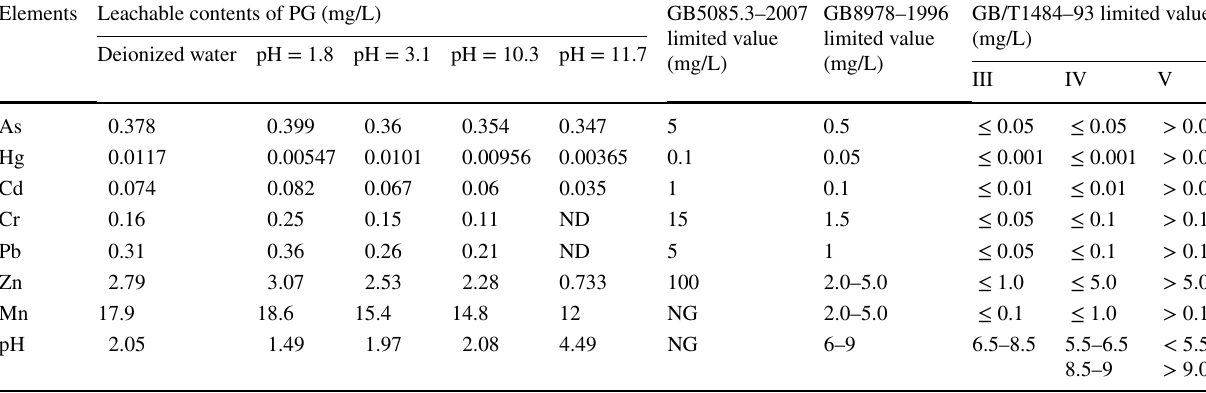
Table 4 Comparison between the leachable contents of the elements in PG gypsum and the national environmental quality standard limits for hazardous pollutants